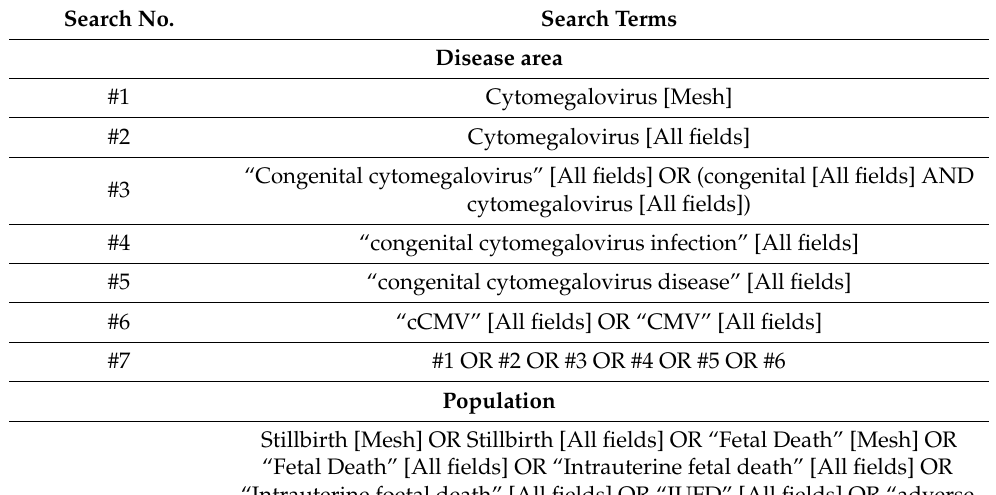
Table 1. PubMed search